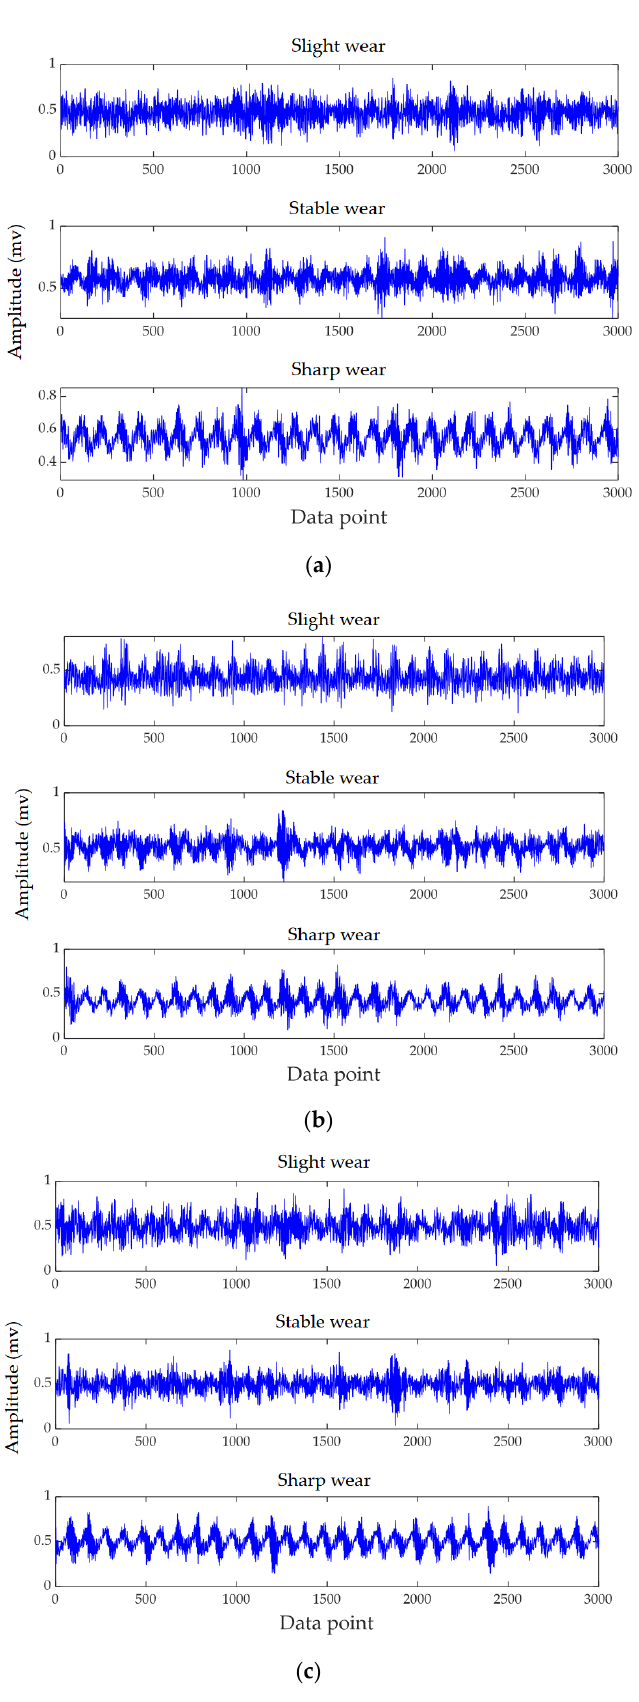
Figure 5. Time domain signals in different wear conditions. ( a ) Tool 1, ( b ) Tool 2, and ( c ) Tool 3.